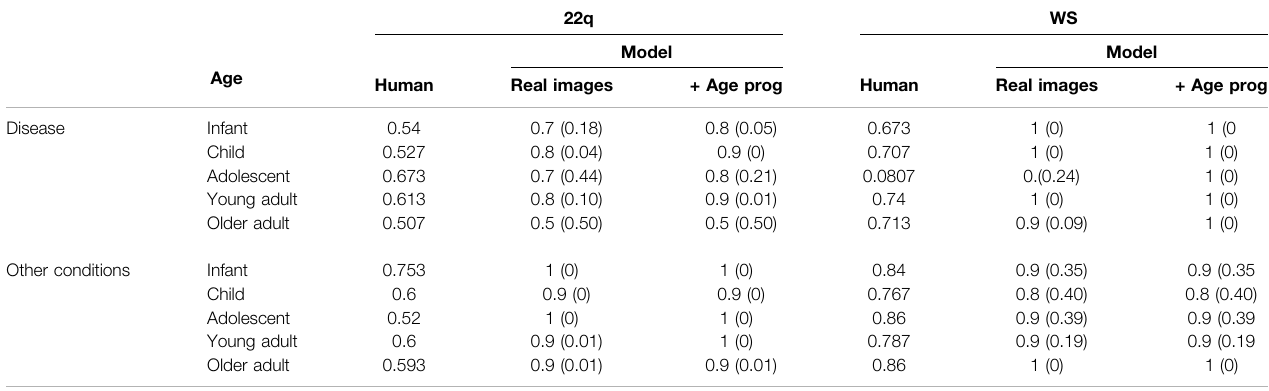
TABLE 1 | Average accuracy over all 10 test images in each age group. Each test image was viewed and classi fi ed by 15 clinical geneticists. Our classi fi er, either trained on realimagesaloneoronbothrealandGANageprogression(ageprog)images,obtainshigheraccuracyforeachagegroup,exceptfortheoldest22qcohort. P -valuesin parentheses comparing the human against model were computed via the permutation